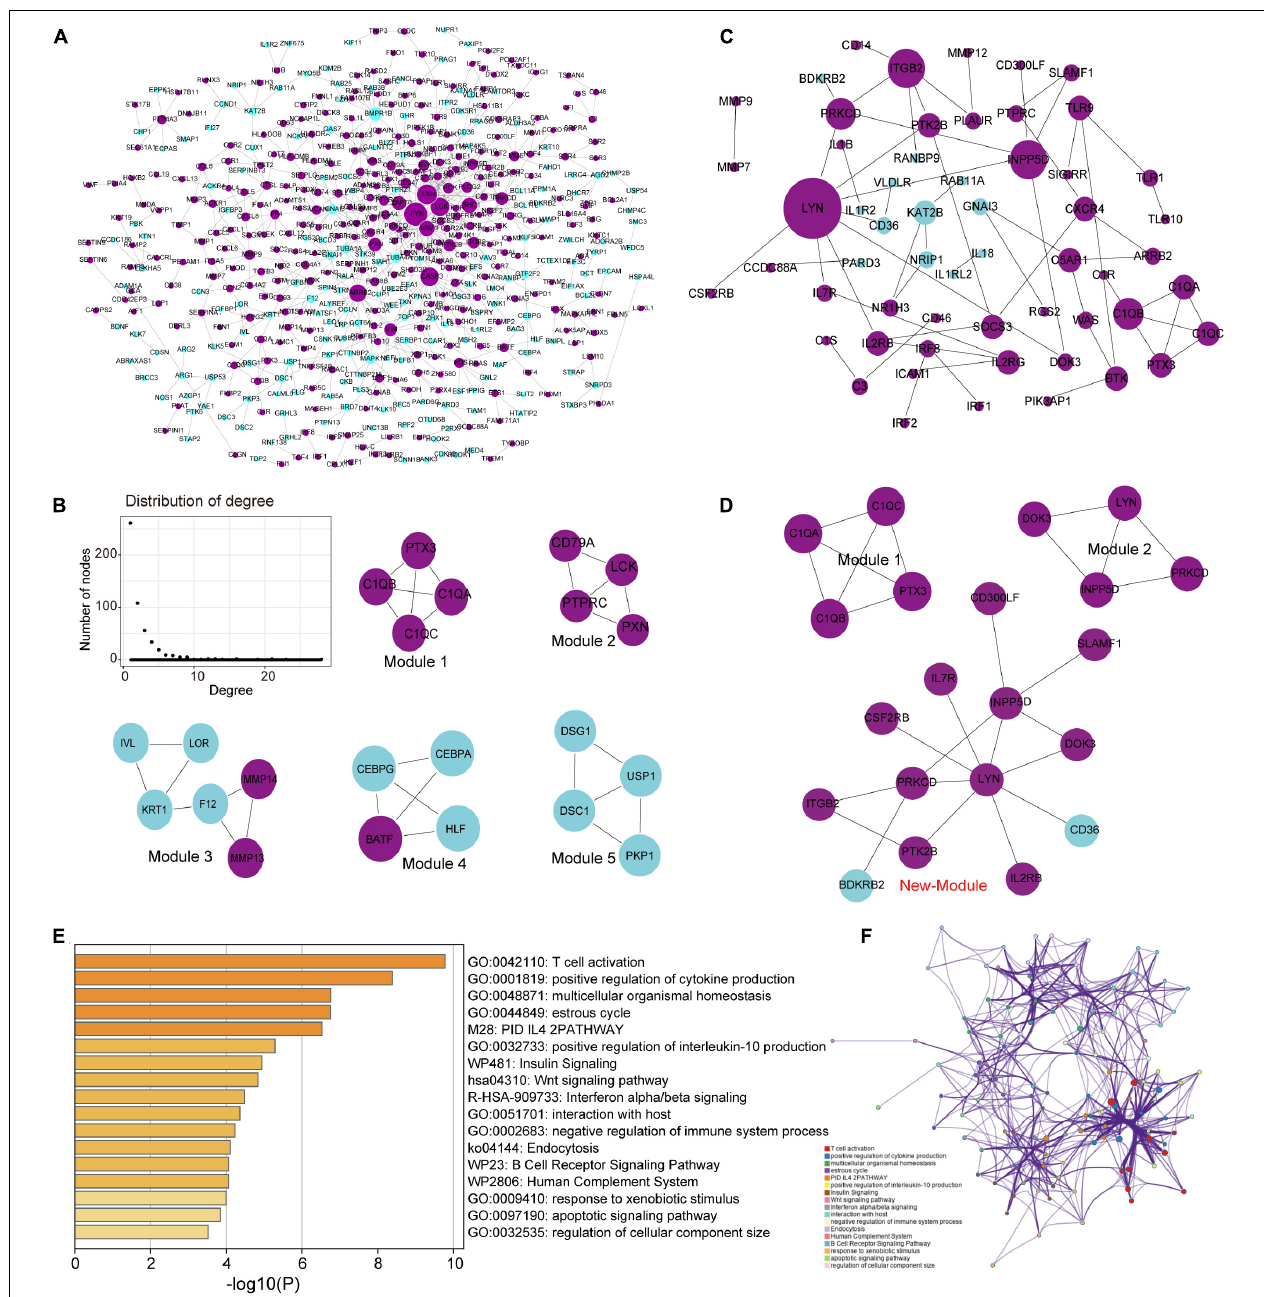
FIGURE 4 | Analysis of the topological properties and functional modules of the PPI network of DEGs and crosstalk genes. (A) This picture represents the protein interaction network of two series of integrated DEGs. There are 647 relationship pairs and 515 nodes in the network. (B) This picture is a moderate topological analysis of the PPI network of DEGs and the five functional modules in the network. (C) This picture shows the PPI network of crosstalk gene, which has 58 relational pairs and 57 nodes. (D) This picture is the three modules in the PPI network of crosstalk gene. (E) Bar graph of enriched terms across TF and target genes associated with immune pathways, colored by p-values. (F) Network of enriched terms colored by cluster ID, where nodes that share the same cluster ID are typically close to each